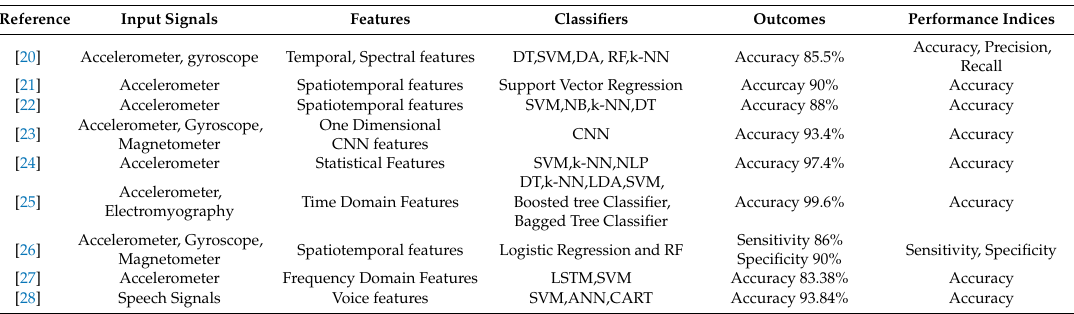
Table 1. Related